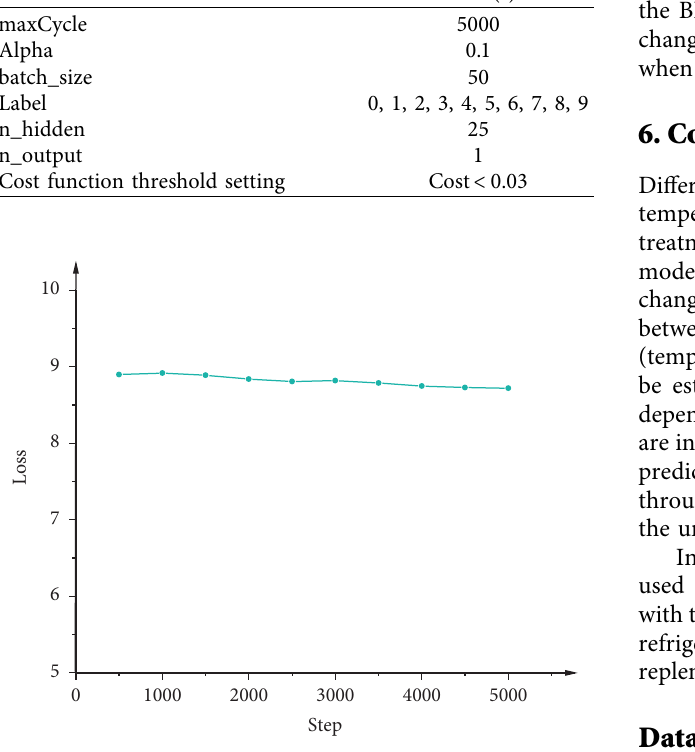
Figure 11: Loss function of RBF